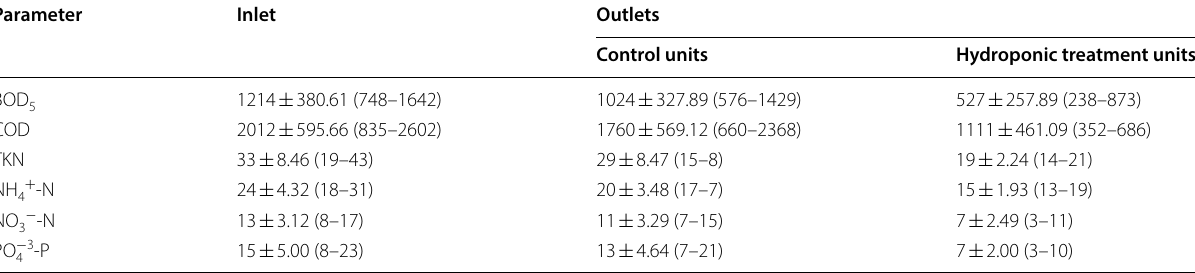
Minimum and maximum concentrations (mg l − 1 ) are indicated in brackets